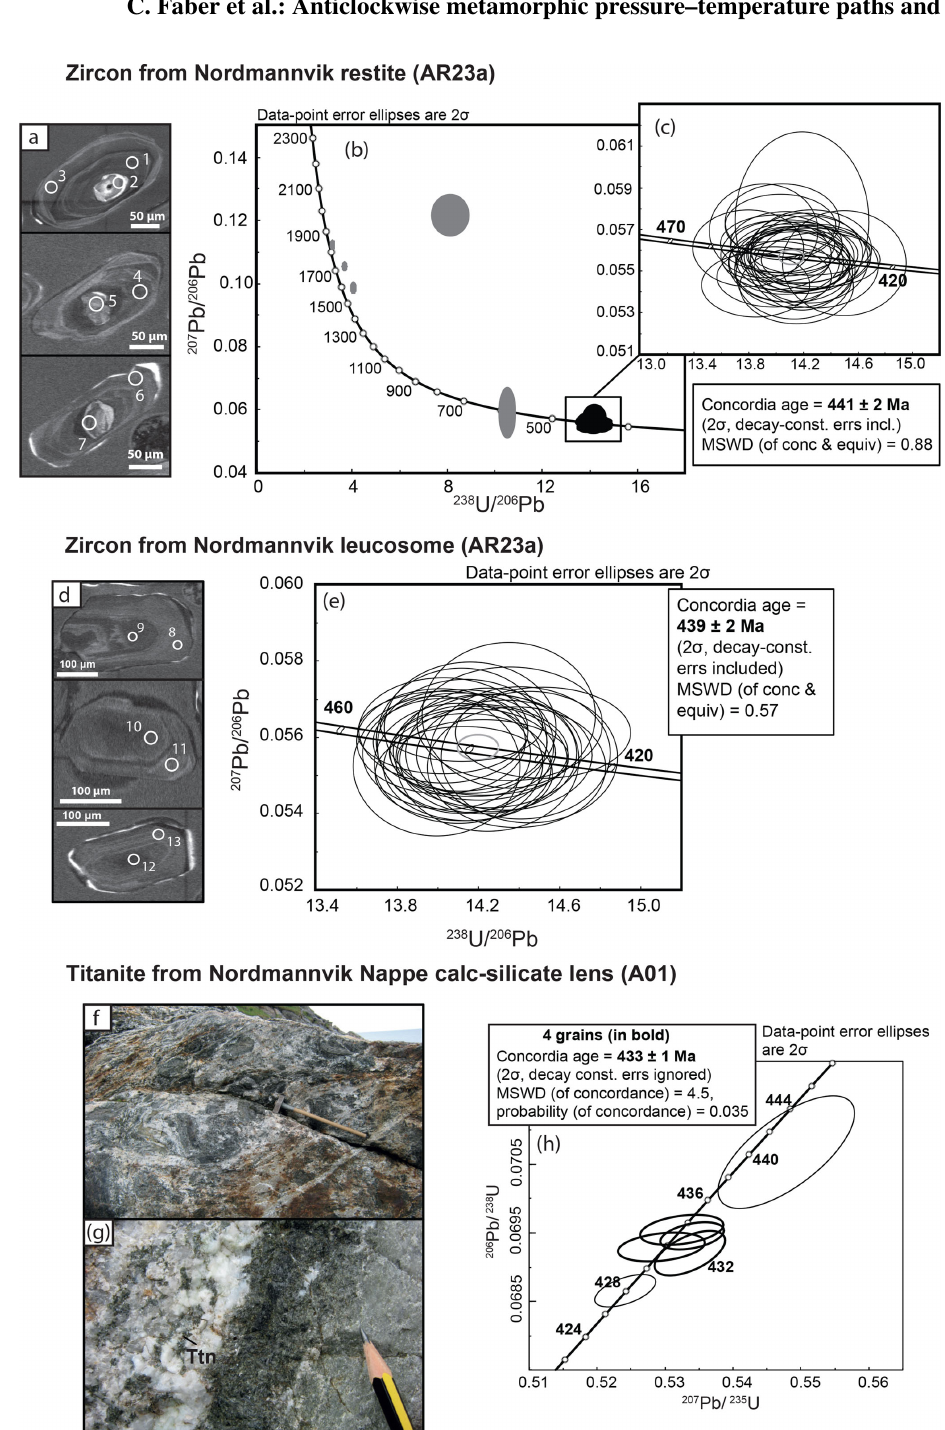
Figure 11. Age of partial melting and metamorphism in the Nordmannvik Nappe. (a) CL images of zircon grains with single spot analyses. 206 Pb / 238 U dates for spot analyses are as follows: (1) 440 ± 5, (2) 585 ± 8, (3) 439 ± 5, (4) 441 ± 5, (5) 1421 ± 16, (6) 443 ± 5, and (7) 1547 ± 17Ma. Note the presence of small, inherited cores. (b) Terra–Wasserburg diagram for SIMS zircon analyses from the restite of sample AR25b. Inherited core analyses are shown as grey ellipses. (c) Concordia diagram with age calculated for the young cluster of zircons in (b) . (d) CL images of zircon grains from the sample with single spot analyses. 206 Pb/ 238 U dates for spot analyses are as follows: (8) 441 ± 5, (9) 440 ± 5, (10) 441 ± 5, (11) 435 ± 5, (12) 438 ± 5, and (13) 434 ± 6Ma. No inherited cores were observed in this sample. (e) Terra–Wasserburg diagram and concordia age for SIMS zircon analyses from the leucosome of sample AR25b. (f) Calc-silicate and leucosome mixing zone at sample site A01. (g) Close-up of calc-silicate and leucosome boundary showing titanite in a schlieren. (h) Concordia diagram for U-Pb TIMS analyses of titanites from a calc-silicate lens in the Nordmannvik Nappe (sample A01) with concordia age calculated for four overlapping analyses (in bold). The mean square of weighted deviates (MSWD) is also shown. Solid Earth, 10, 117–148, 2019